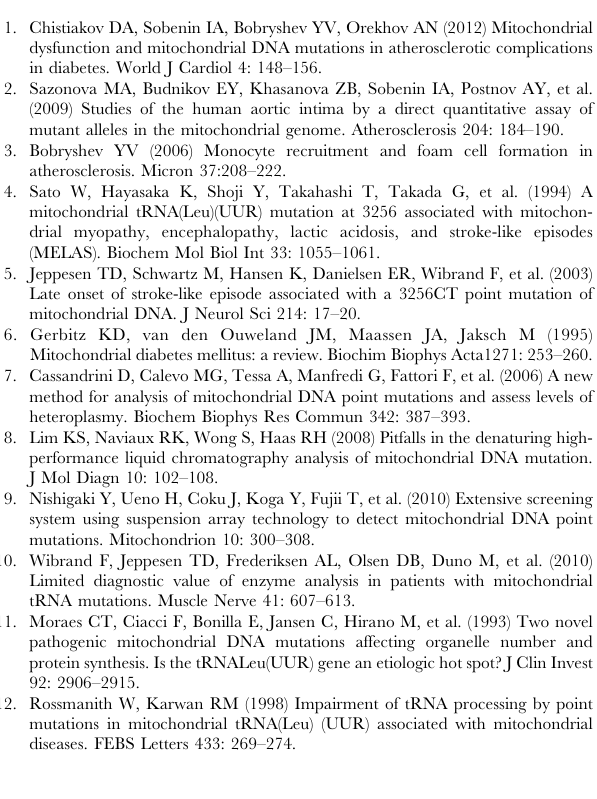
Figure S1 Different ultrastructural appearances